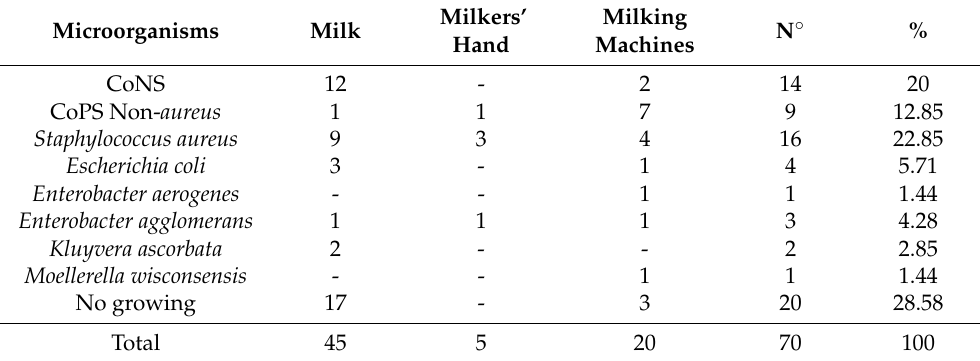
Table 1. Frequency of microorganisms isolated in milk samples, hand swabs from milkers and milking machines, in the municipality of Boa Esperança, northwest of the State of Paran á , Brazil, May–June 2022. Microorganisms Milk